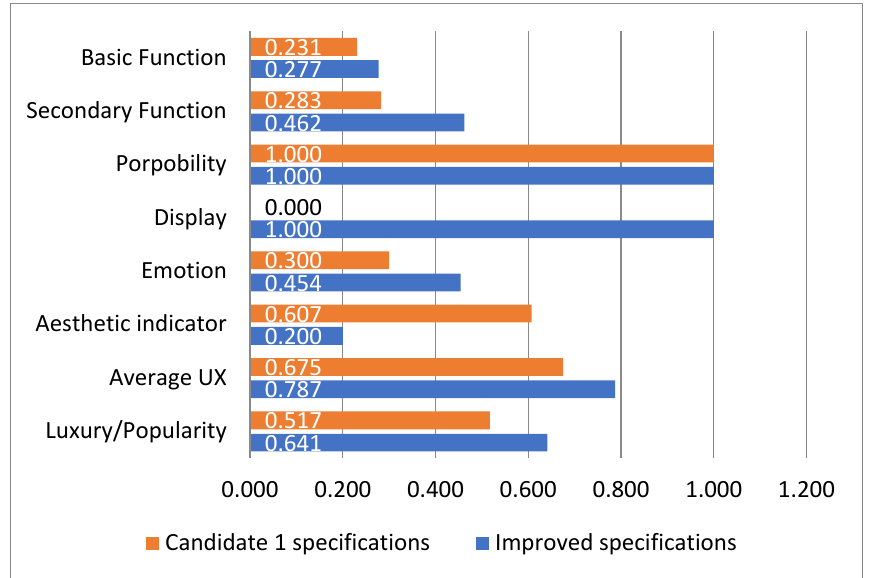
Figure 9. GA optimization results of design specification candidate.